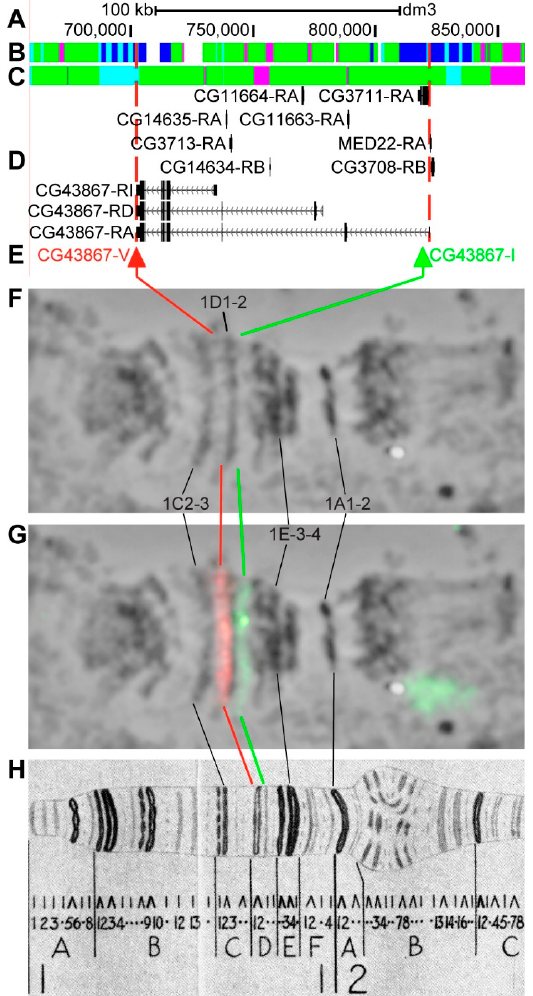
Figure 7. Localization of the CG43867 gene in the 1CD region (the gene is bound by red dotted lines). (A) the scale (kb) and genomic coordinates (bp); (B) the four chromatin-state model [39]; (C) the chromatin condensation level model [32]; (D) genes location (arrow lines show the gene orientation and black bars indicate the location of gene exons); (E) probes location; (F) phase-contrast micrograph of the region; (G) combined FISH signals; and, (H) C. Bridges’ chromosome map [25].